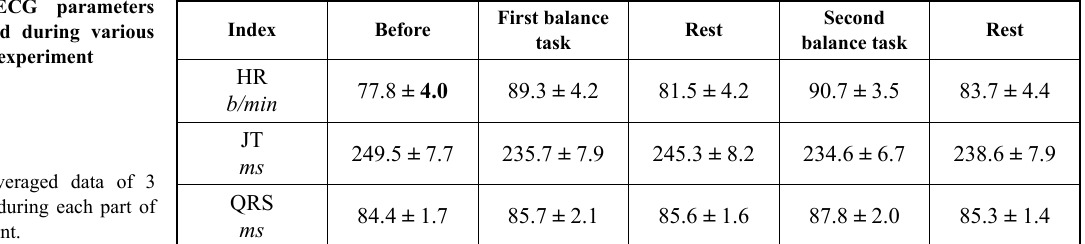
Note. Averaged data of 3 minutes during each part of experiment.